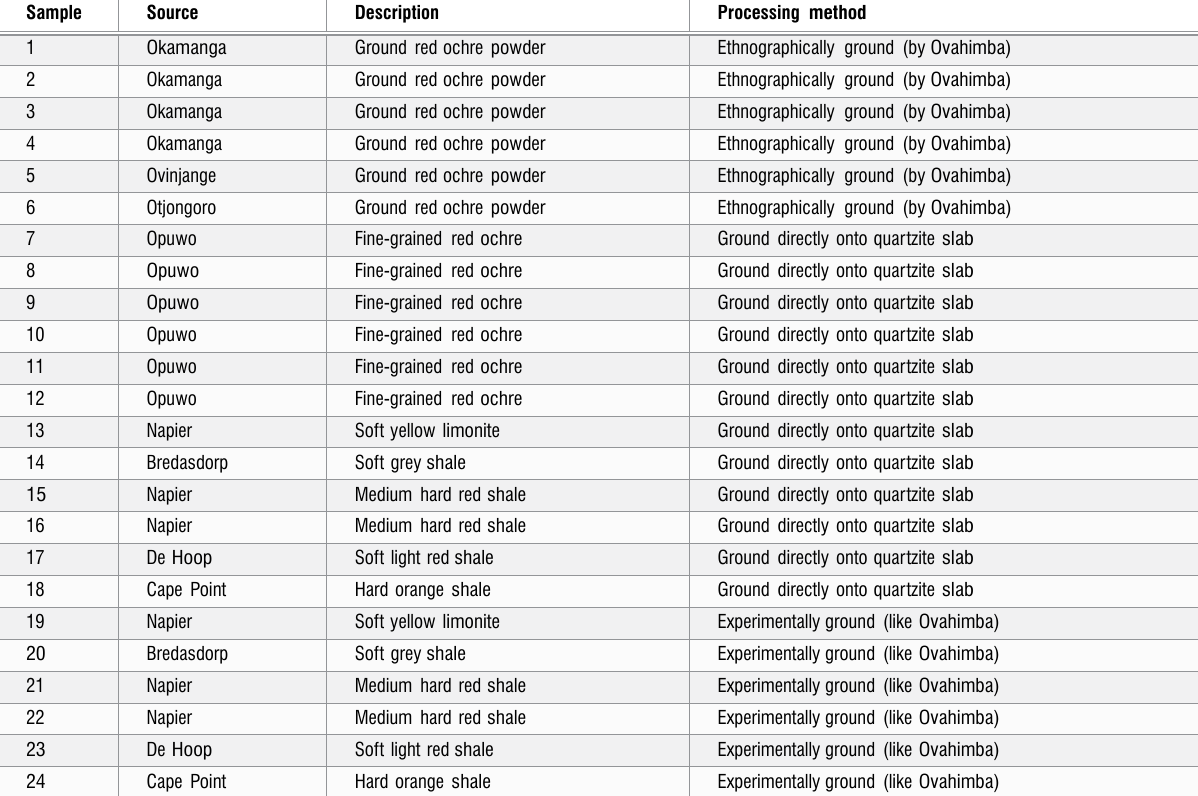
Experimental ochre samples subjected to in vitro ultraviolet radiation analyses